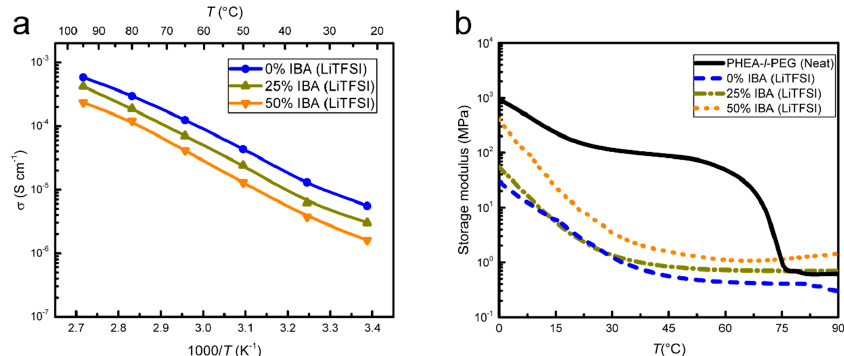
Figure 4. Comparison of SPE-2 with SPE-1 at an LiTFSI concentration of r = 0.08. SPE-2 with LiTFSI shows ( a ) an increase in conductivity as a function of temperature for all samples, as determined by EIS. Replacing 25% and 50% of HEA in SPE-1 by isobornyl acrylate (IBA) (resulting in SPE-2) shows a conductivity decrease with increasing IBA content. ( b ) DMA of SPE-2 shows an increase in the temperature-dependent storage modulus with increasing IBA content.